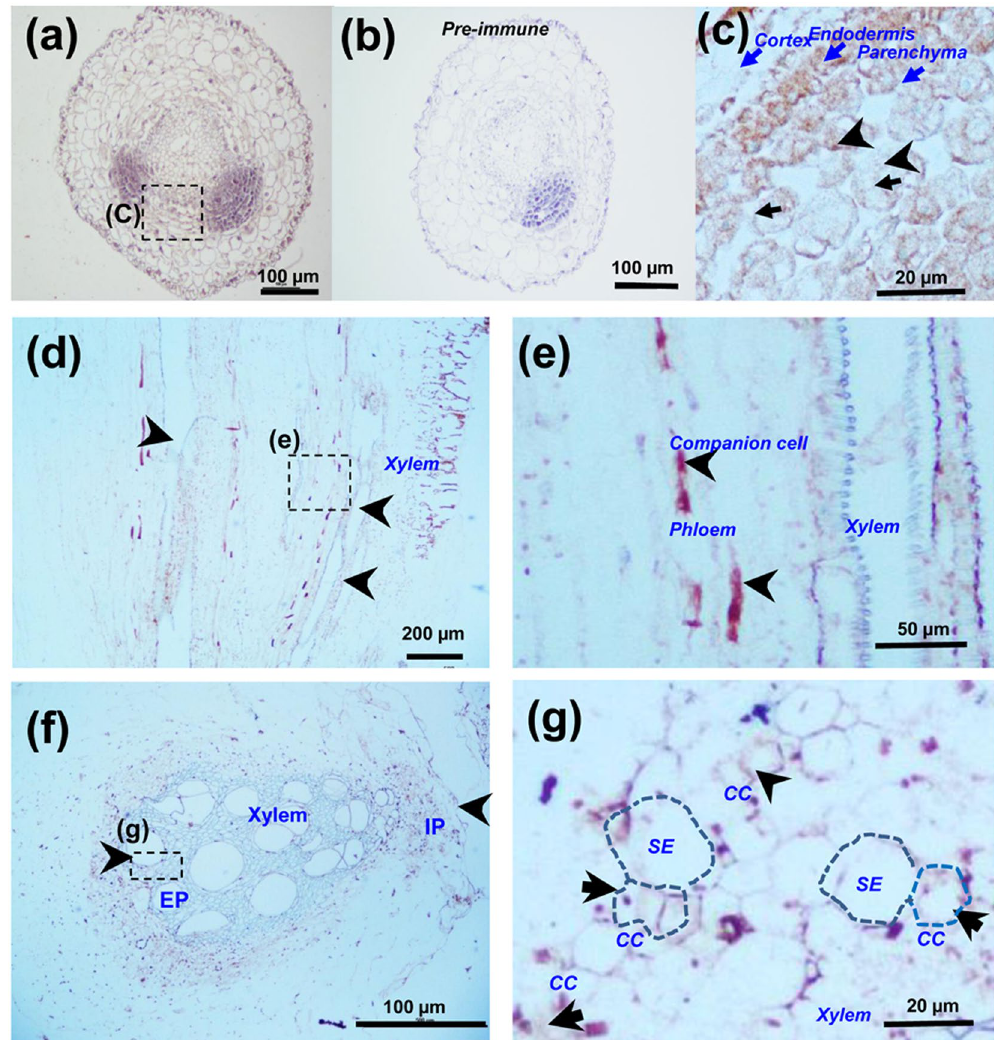
Figure 4. Immunohistochemical analysis of CsGPA1 in cucumber leaves, root tips, and stems. Anti-CsGPA1 monoclonal antibody was used to analyze transverse sections of the root tips of 4-leaf-old plants ( a–c ). Control section treated with pre-immune serum revealing the absence of immunoreactivity in the root tip ( b ). Longitudinal sections of the petioles of 15-d-old plants ( d , e ), and stem cross sections of 30-d-old plants ( f , g ). ( c ) Magnified view of images in ( a ). ( e , g ) Magnified view of the images in the boxes of (d and f). Scale = 20, 50, 100, and 200 µ m. Black arrows, nucleus; blue arrows, cell layers of root meristem; black arrowheads indicate the specific distributions of immunostaining in the root tip cortex, epidermal, endodermal, parenchymal, phloem cells, sieve elements, and companion cells. SE, sieve element; CC, companion cells; X, xylem; EP, external phloem; IP, internal